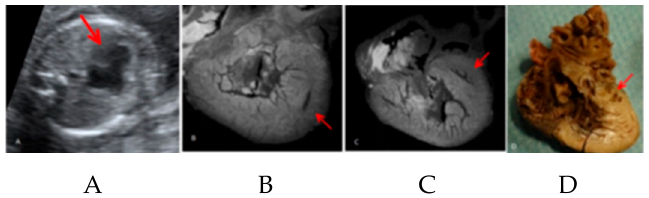
Figure 3. The diagnostic ability of micro-CT with prenatal fetal echocardiography and autopsy in a case of hypoplastic left heart syndrome. ( A ) Prenatal ultrasound: four chambers view shows the hypoplastic mitral valve and left heart (red arrow); ( B ) postmortem micro-CT at the level of the ventricle compares the right ventricle with the hypoplastic left ventricle (red arrow); ( C ) four-chamber view at postmortem micro-CT shows the hypoplastic left ventricle (red arrow); ( D ) four-chamber view at conventional autopsy shows the hypoplastic left ventricle (red arrow) [29].